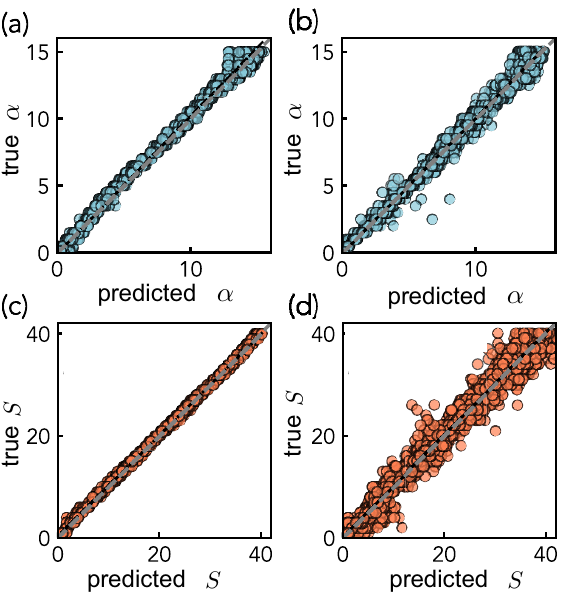
Figure 2. Aggregated true and predicted scatter plots from tenfold cross validation for ( a ) Bruggeman’s exponent α from L w -model with L s = 5.59% and R 2 = 0.99 , ( b ) α from L M -model with L s = 2.95% and L R 2 = 0.99 , ( c ) shape factor S from L R 2 = 1.0 , and ( d ) S from L w -model with s = 0.89% and M -model with L R 2 = 0.97 . Overall, the trained model accurately predicts both α and S . Specifically, the L s = 2.59% and w -model performed better at predicting S with 1.70% less error throughout the range of S values, while the L M - model was better at predicting α < 3.0 by over 5% in comparison to the L w -model. A combination of the model predictions was adopted for the final